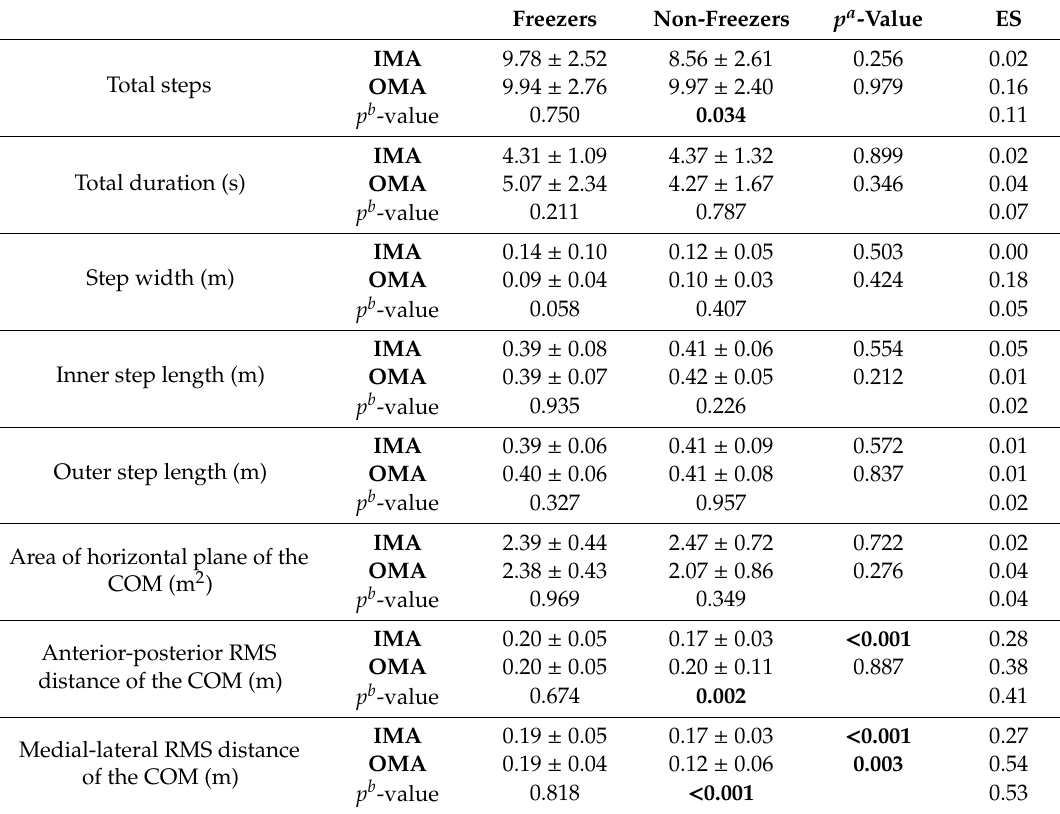
Figure 3. Single participant trial of freezers, non-freezers, and controls during the 360 ◦ and 540 ◦ turning tasks. This figure presented the horizontal trajectory of the center of mass presented by large (a freezer) and small (a non-freezer) solid dots, and full line (a control), respectively. Table 4. Comparison of turning characteristics of freezers and non-freezers for the 360 ◦ turning task at maximum